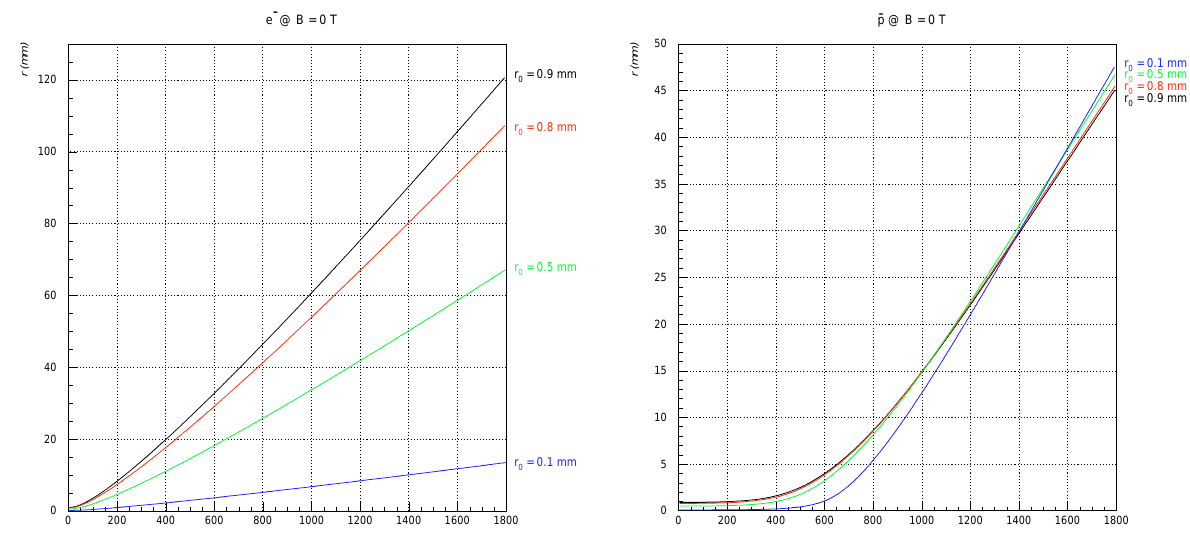
FIG. 1. (Color) Expansion of the electron beam due to self-field (left) and trajectories of electrons inside (cid:197) (cid:112) bunch (right).